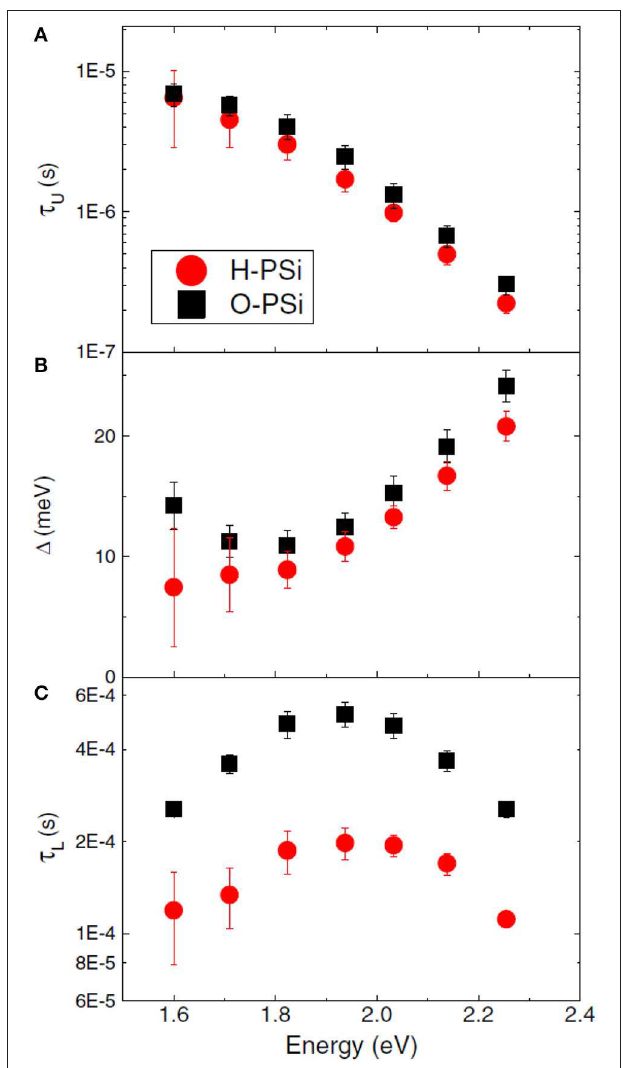
FIGURE 4 | Comparison of hydrogen terminated and oxidized porous silicon, showing (A) upper singlet lifetimes, (B) excitonic energy splitting, and (C) lower triplet lifetimes. Arad-Vosk et al. [ 52], Springer with permission.